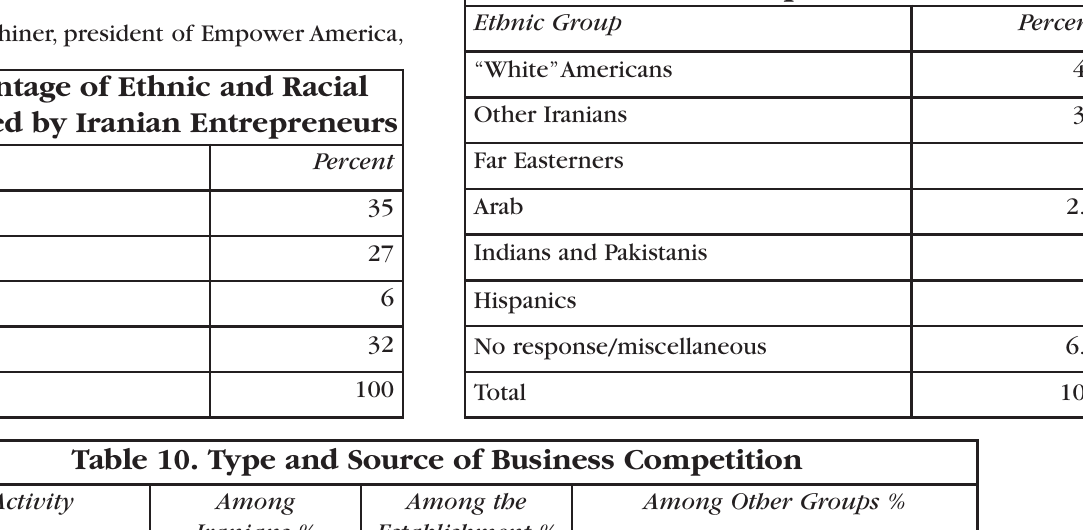
Table 9. The Important Groups of Competitors